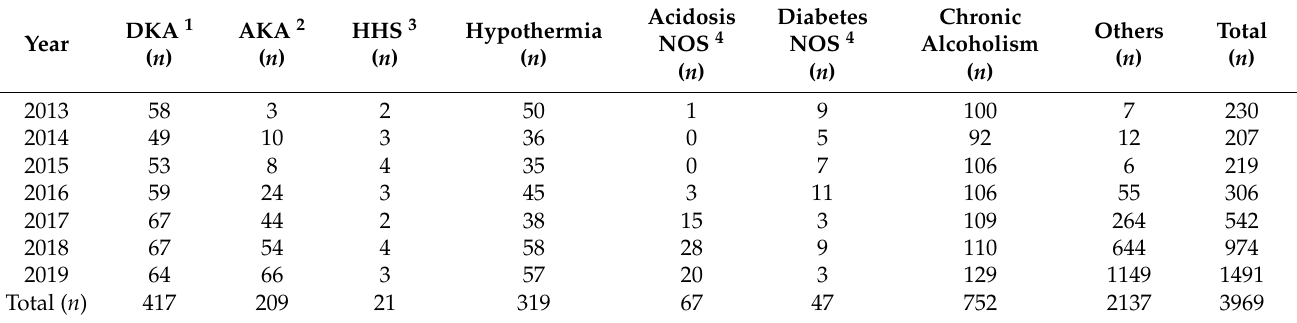
Table 3. Total (Tables 1 and 2